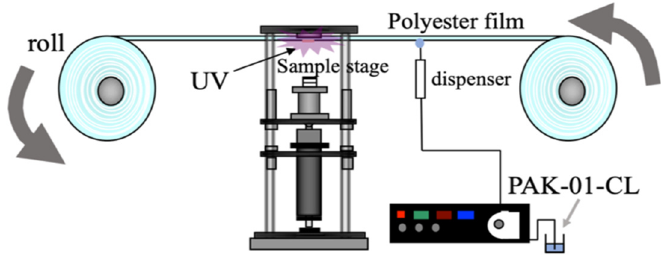
Figure 3. Transfer endurance and barge endurance device.